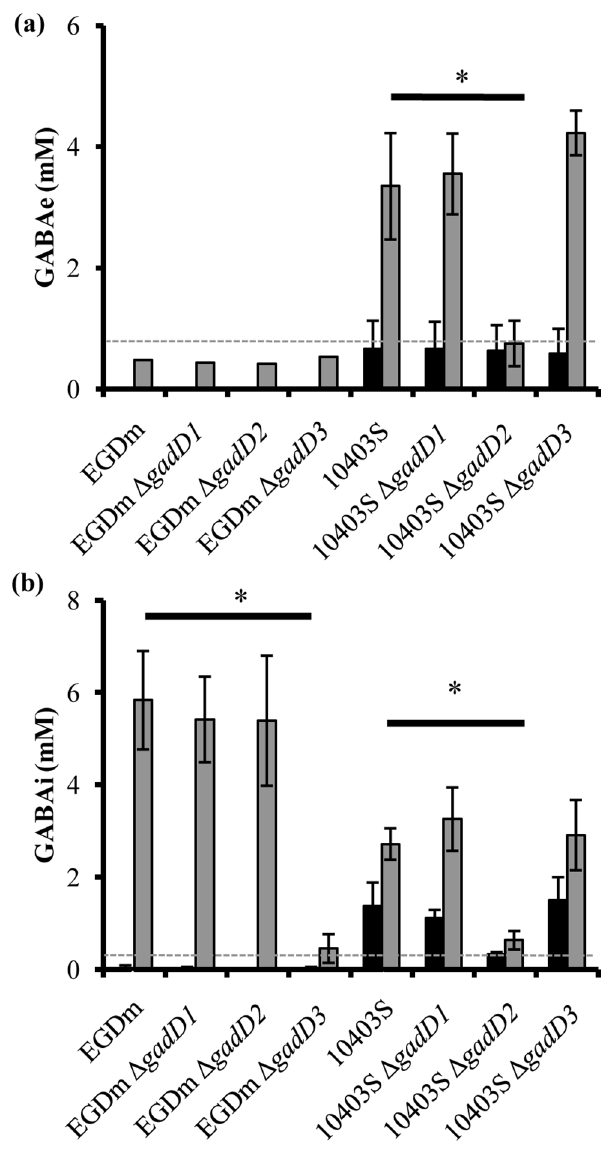
Figure 3. GABA production from L.monocytogenesgad mutants. ( a ) Production of GABA e by EGDm and 10403S gad mutants with (grey) or without (black) 1 h exposure to acid at pH 4.0 (EGDm) or pH 3.5 (10403S). ( B ) Production of GABA i by EGDm and 10403S gadD mutants with (grey) or without (black) 1 h exposure to acid at pH 4.0 (EGDm) or pH 3.5 (10403S). Dashed horizontal lines indicate the detection limits for GABA in each experiment. Error bars represent the standard deviation from the mean of three individual biological repeats for each sample. An asterix represents signifcant difference of less than 0.05 between a given mutant and respective wild-type as determined by a student’s t- test. dominant GAD transcript in EGDm while for 10403S it was gadD2.